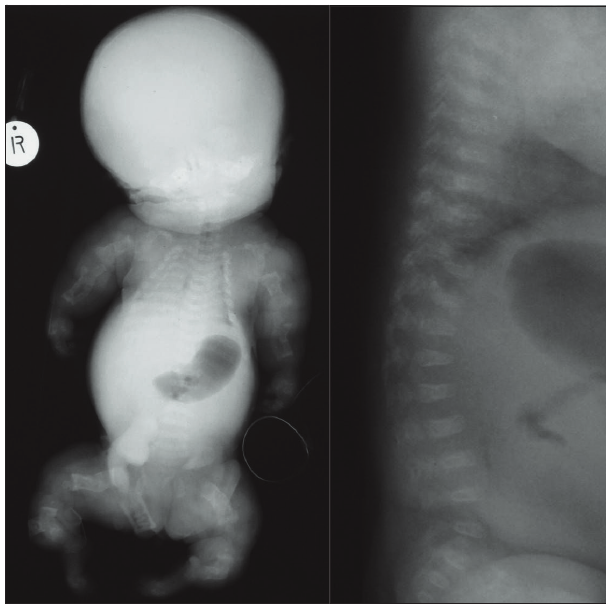
Fig. 3. Babygram X-ray of Patient 2 demonstrating generalised undermineralisation and evidence of multiple fractures. The skull is poorly ossified. The ribs show continuous beading. All long bones are short and broad with crumpled